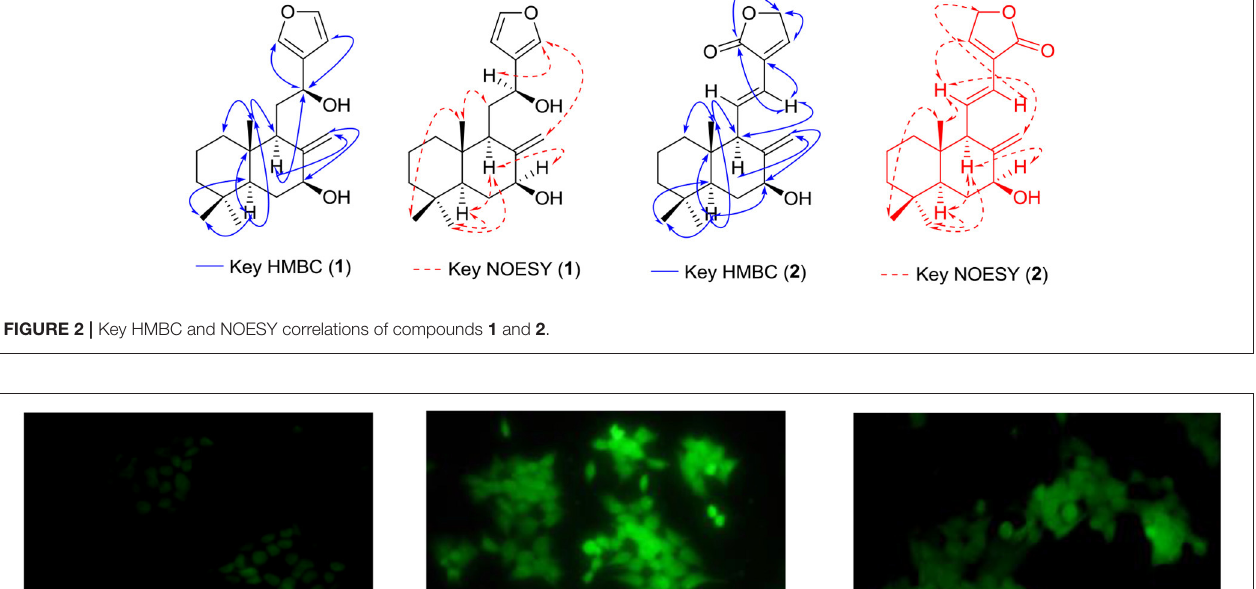
Frontiers in Chemistry |